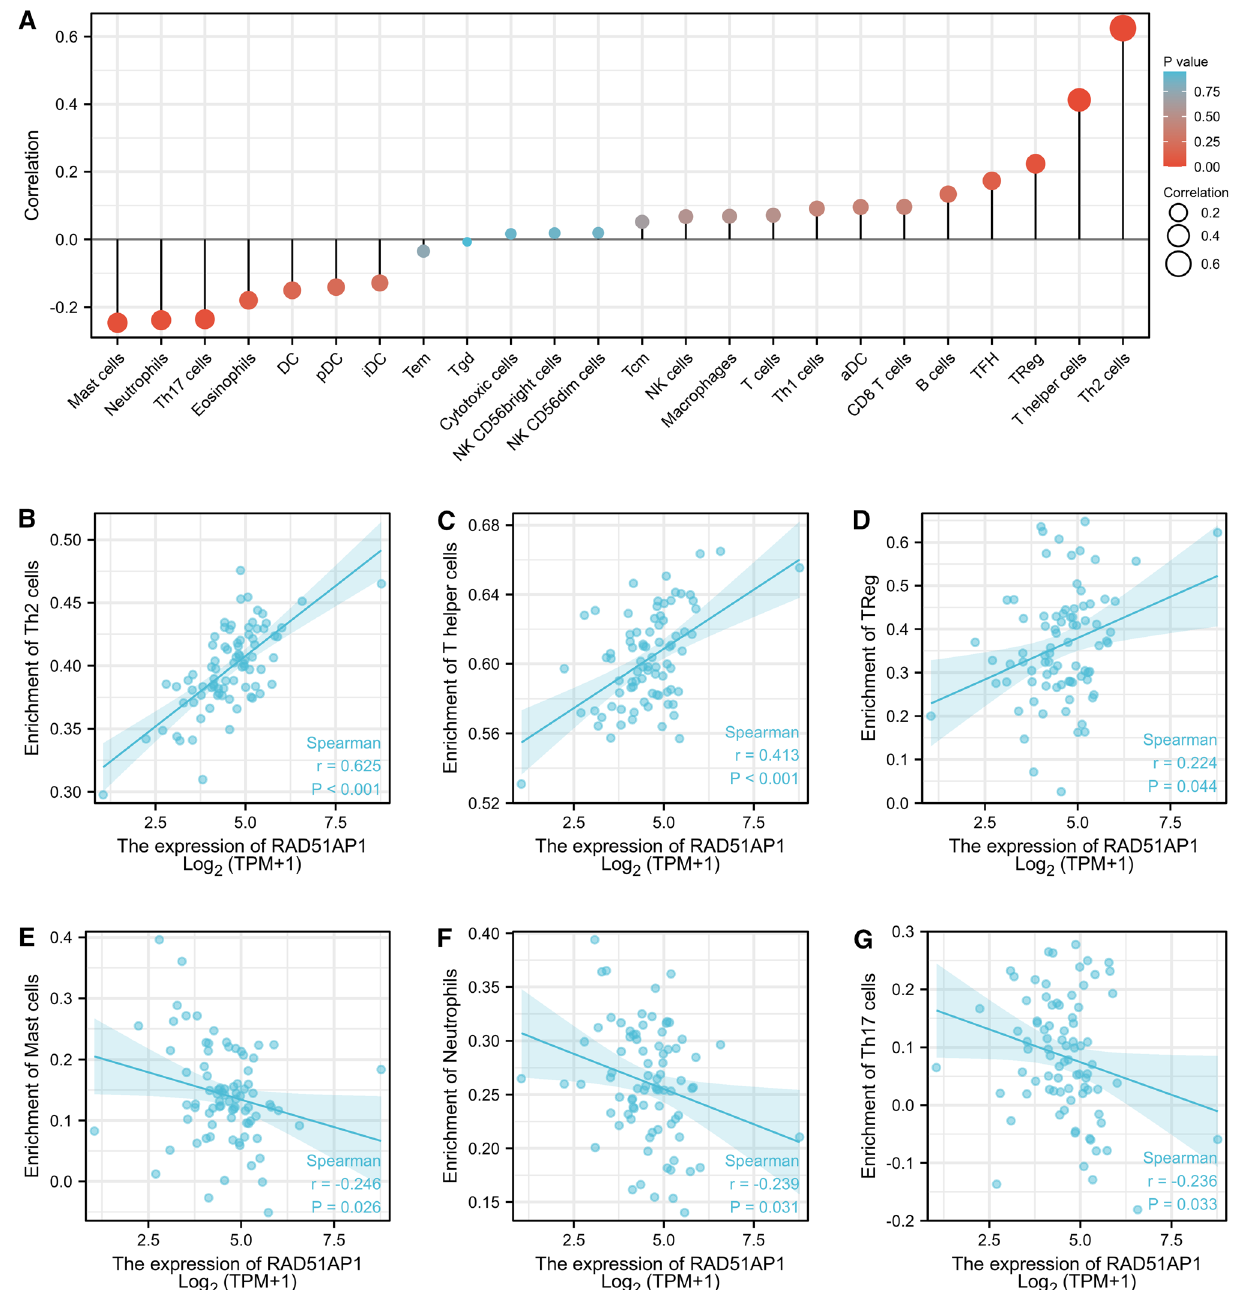
Fig. 3 The correlation between RAD51AP1 expression and immune filtration level in ESCC. A The correlation between infiltration level of immune cells and RAD51AP1 expression in ESCC. B – D RAD51AP1 expression was positively associated with the enrichment of Th2 cells, T helper cells, and Treg cells. E – G RAD51AP1 expression was negatively associated with the enrichment of Mast cells, Neutrophils cells and Th17